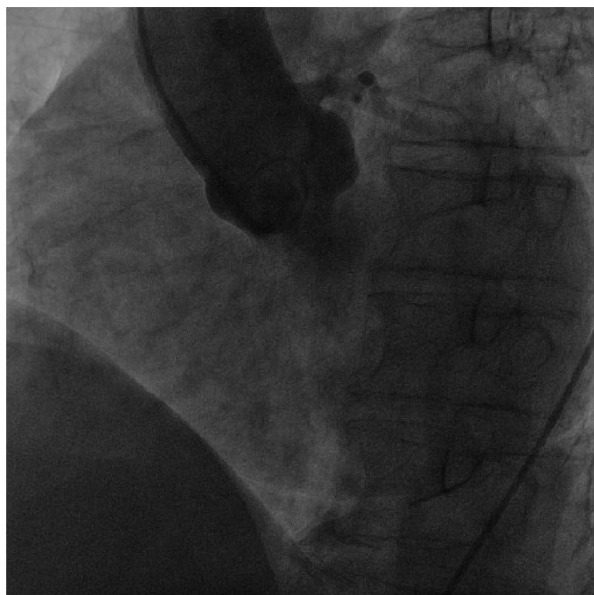
Figure 3 - No right coronary ostium was observed using aortography.